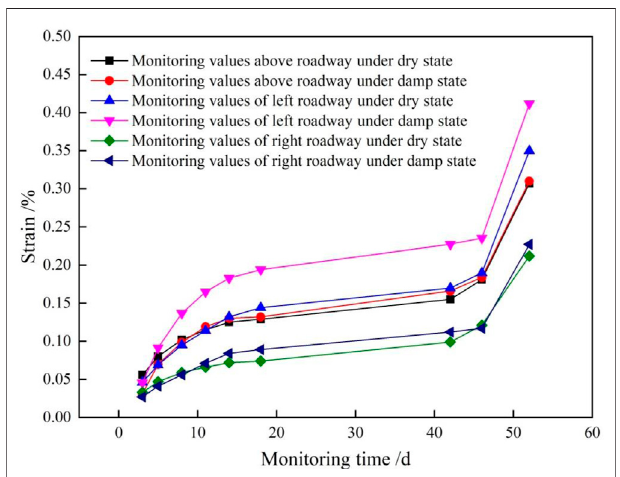
FIGURE 8 | Relationship of strain-time under dry and damp states.